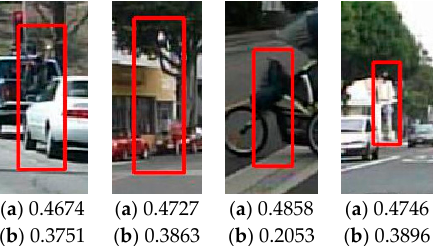
Figure 13. Scores for false positive samples (in red boxes) of the Caltech. ( a ) Scores by the Global network, ( b ) scores by the two-stream UDN.